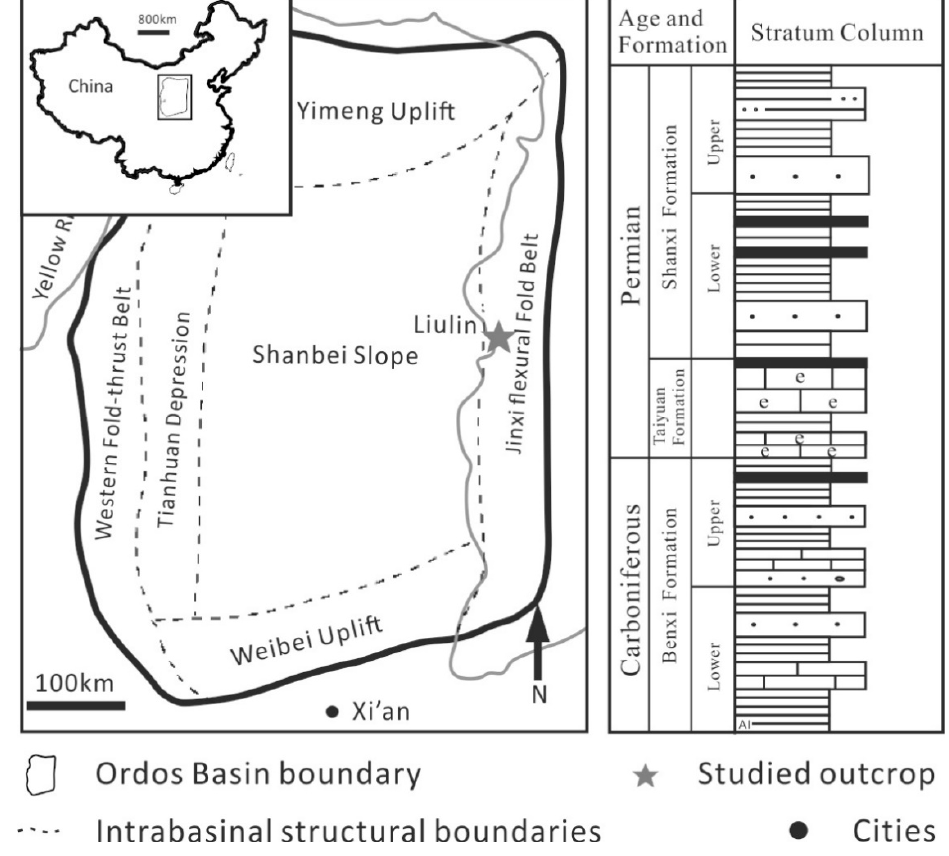
Figure 1. Tectonic map and stratum column of the Ordos Basin and location of the study outcrop. The Carboniferous Benxi Formation in the studied area consists of a ~68 m thick barrier island and lagoonal deposits. The basal part is composed of limonite/hematite with nest-like structure and bauxite layers, the middle part is composed of lagoonal carbonaceous shales with interbedded siderite lenses and tidal channel sandstones, while the upper part is composed of barrier island facies sandstones, carbonaceous shales, and coals. The Carboniferous Taiyuan Formation is ~54 m thick tidal flat-shelf deposits, consisting of grey − dark grey bioclastic calcareous limestone, interbedded with black shales, coals, and grey − light grey sandstones. The Permian Shanxi Formation is ~82 m thick tidal flat-lagoonal and delta-front facies deposits. The basal part is black shales and silty shales interbedded with coals, and the upper part is grey − greyish white sandstones and dark grey − black shales.